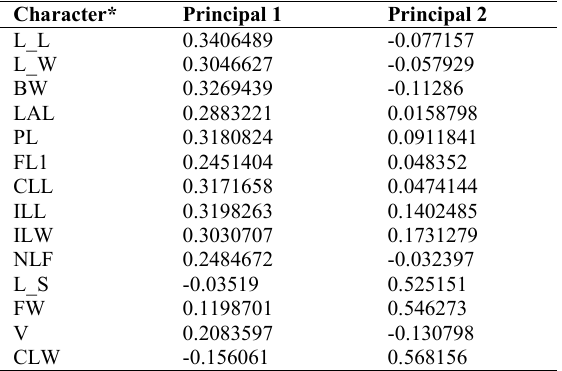
Table 5 . Details of quantitative and qualitative morphological characters were used in the present